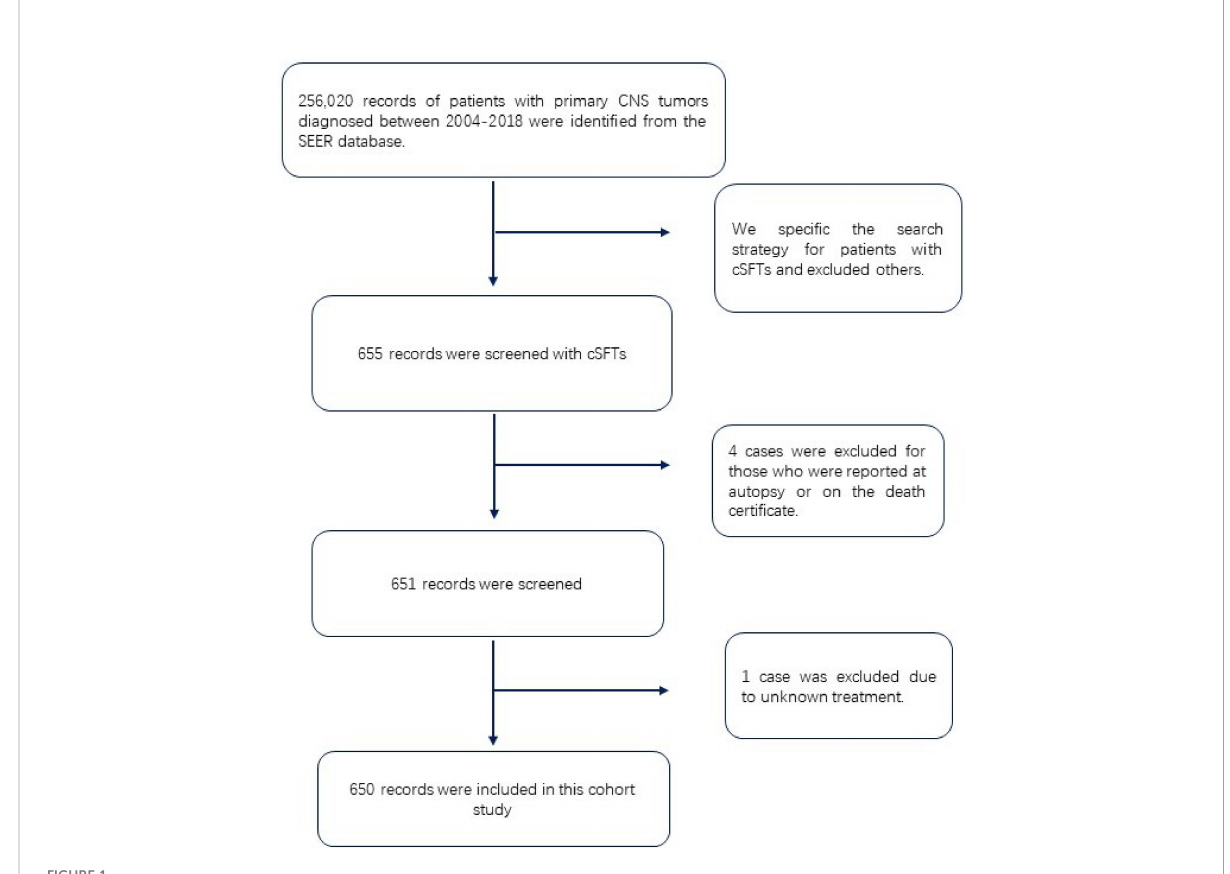
FIGURE 1 Flow diagram of the study.